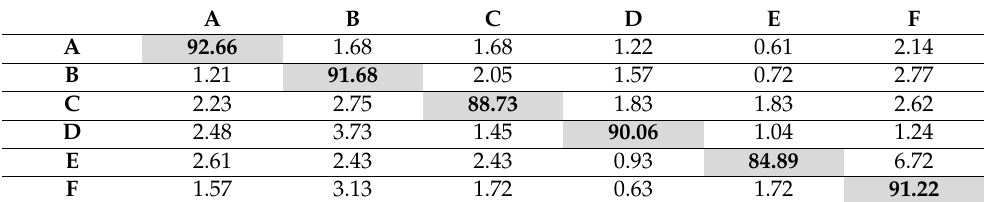
Table 4. Confusion matrix (%) of 2D-DIDGP on Set 2 using SVM with RBF kernel function,